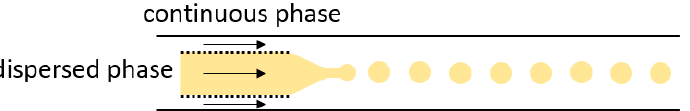
Figure 5. Droplet generation in a co-flowing microfluidic system. Small spherical droplets are formed in the channel resulting in droplet flow.